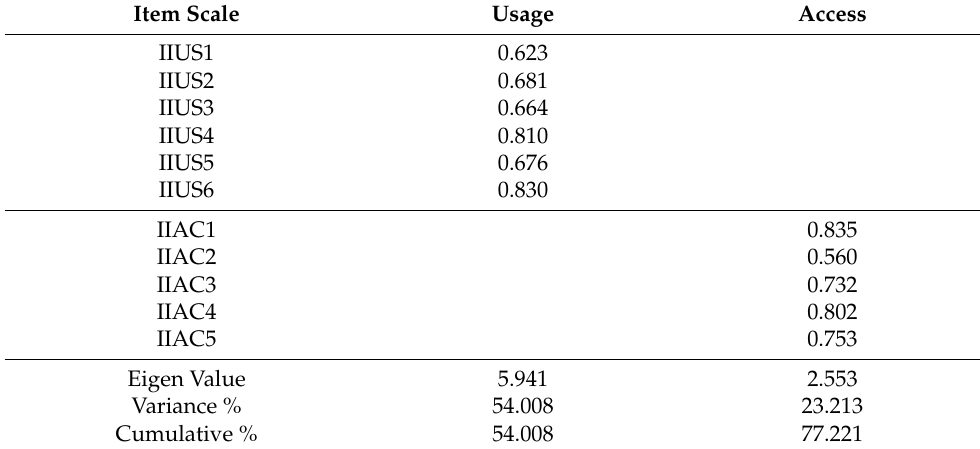
Table 6. Exploratory factor analysis for insurance